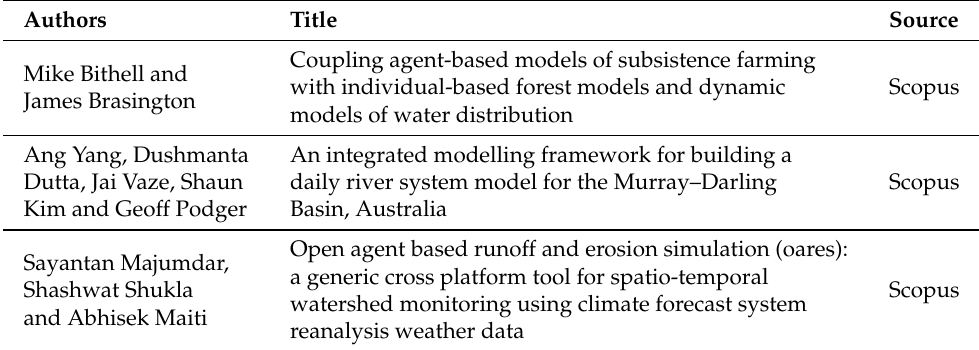
Table 6. Final papers